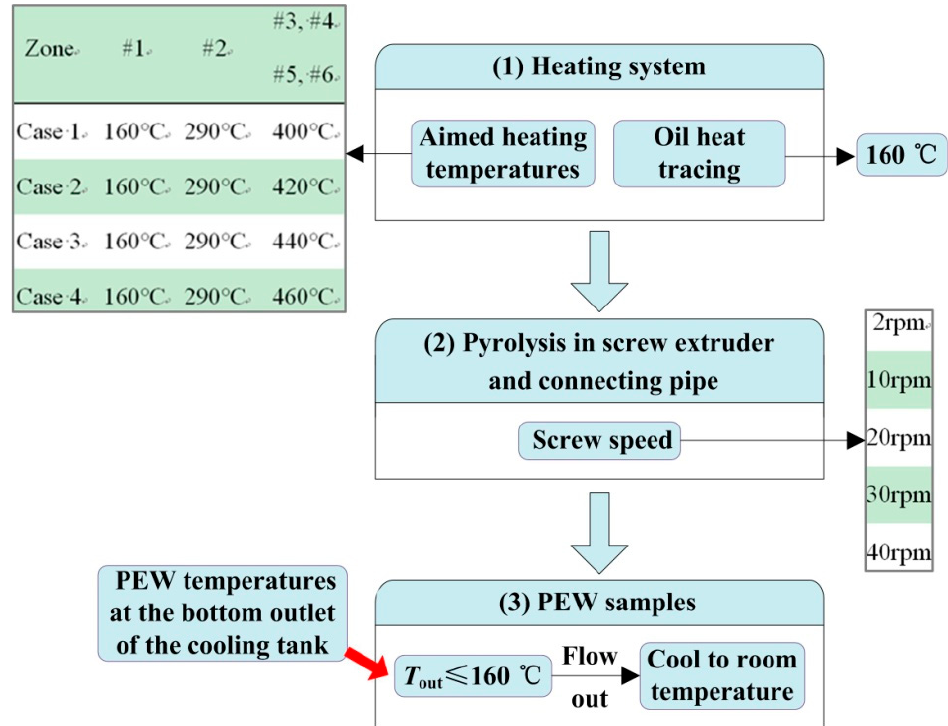
Figure 2. Flowchart of preparation of polyethylene wax (PEW).